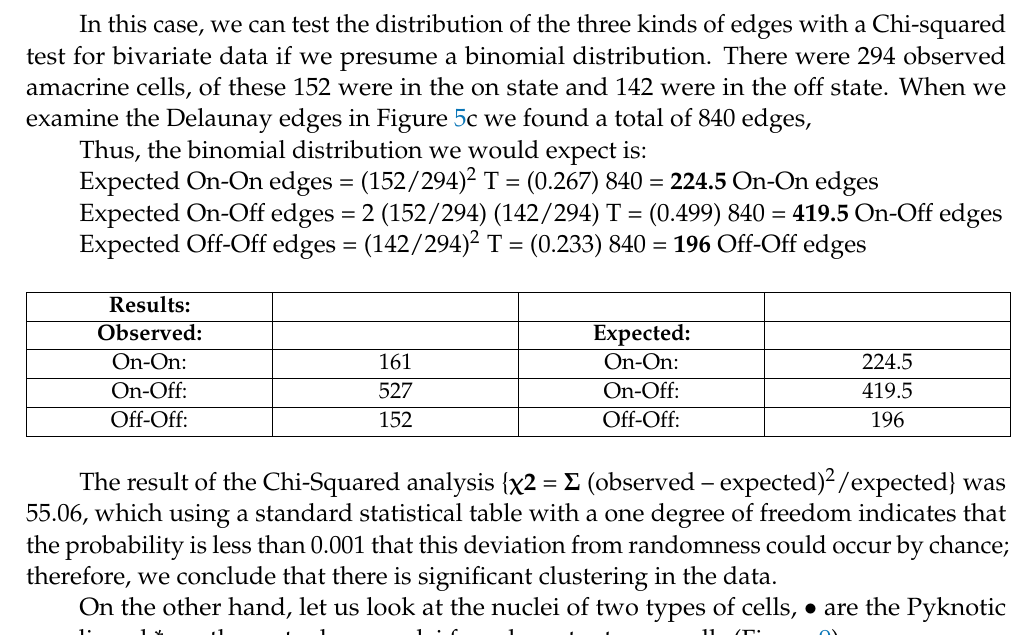
Figure 9. ( a ) Hamster tumor cells data provided by Dr. W. A. Aherne (Department of Pathology, University of Newcastle upon Tyne). The 313 nuclei of two types of cells, • are the 77 Pyknotic nuceli, and * are the 236 metaphase nuclei. ( b ) Using the Ka-me_0_84 program, the points to create both a Voronoi diagram and Delaunay triangulation. ( c ) Edges shared by metaphase-Pyknotic, and dotted lines show the edges Pyknotic-Pyknotic cells share.